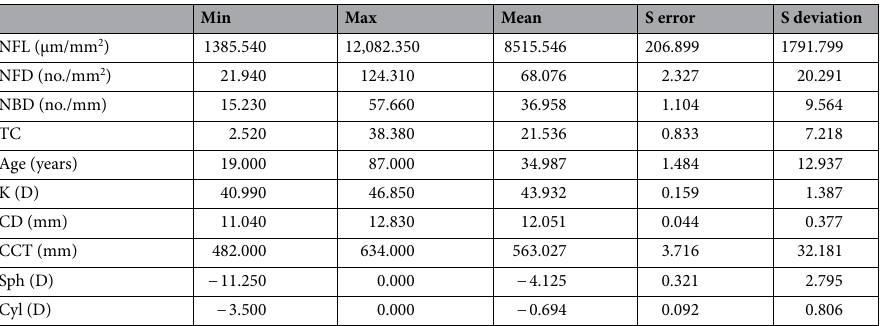
Table 1. Statistical summary of the collected eye data*. *NFL nerve fiber length (µm/mm 2 ), NFD nerve fiber density (no./mm 2 ), NBD nerve beadings density (no./mm), TC tortuosity coefficient, K corneal curvature ( D diopters), CD corneal diameter (mm), CCT corneal thickness (µm), Sph sphere ( D diopters), Cyl cylinder ( D